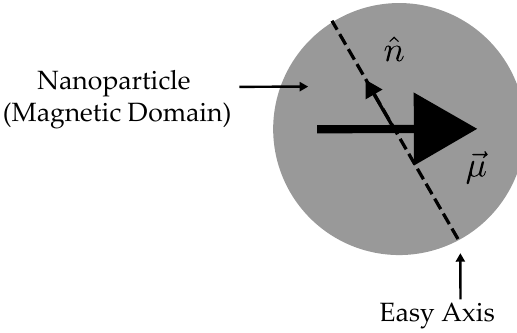
Figure 1. Magnetic nanoparticle